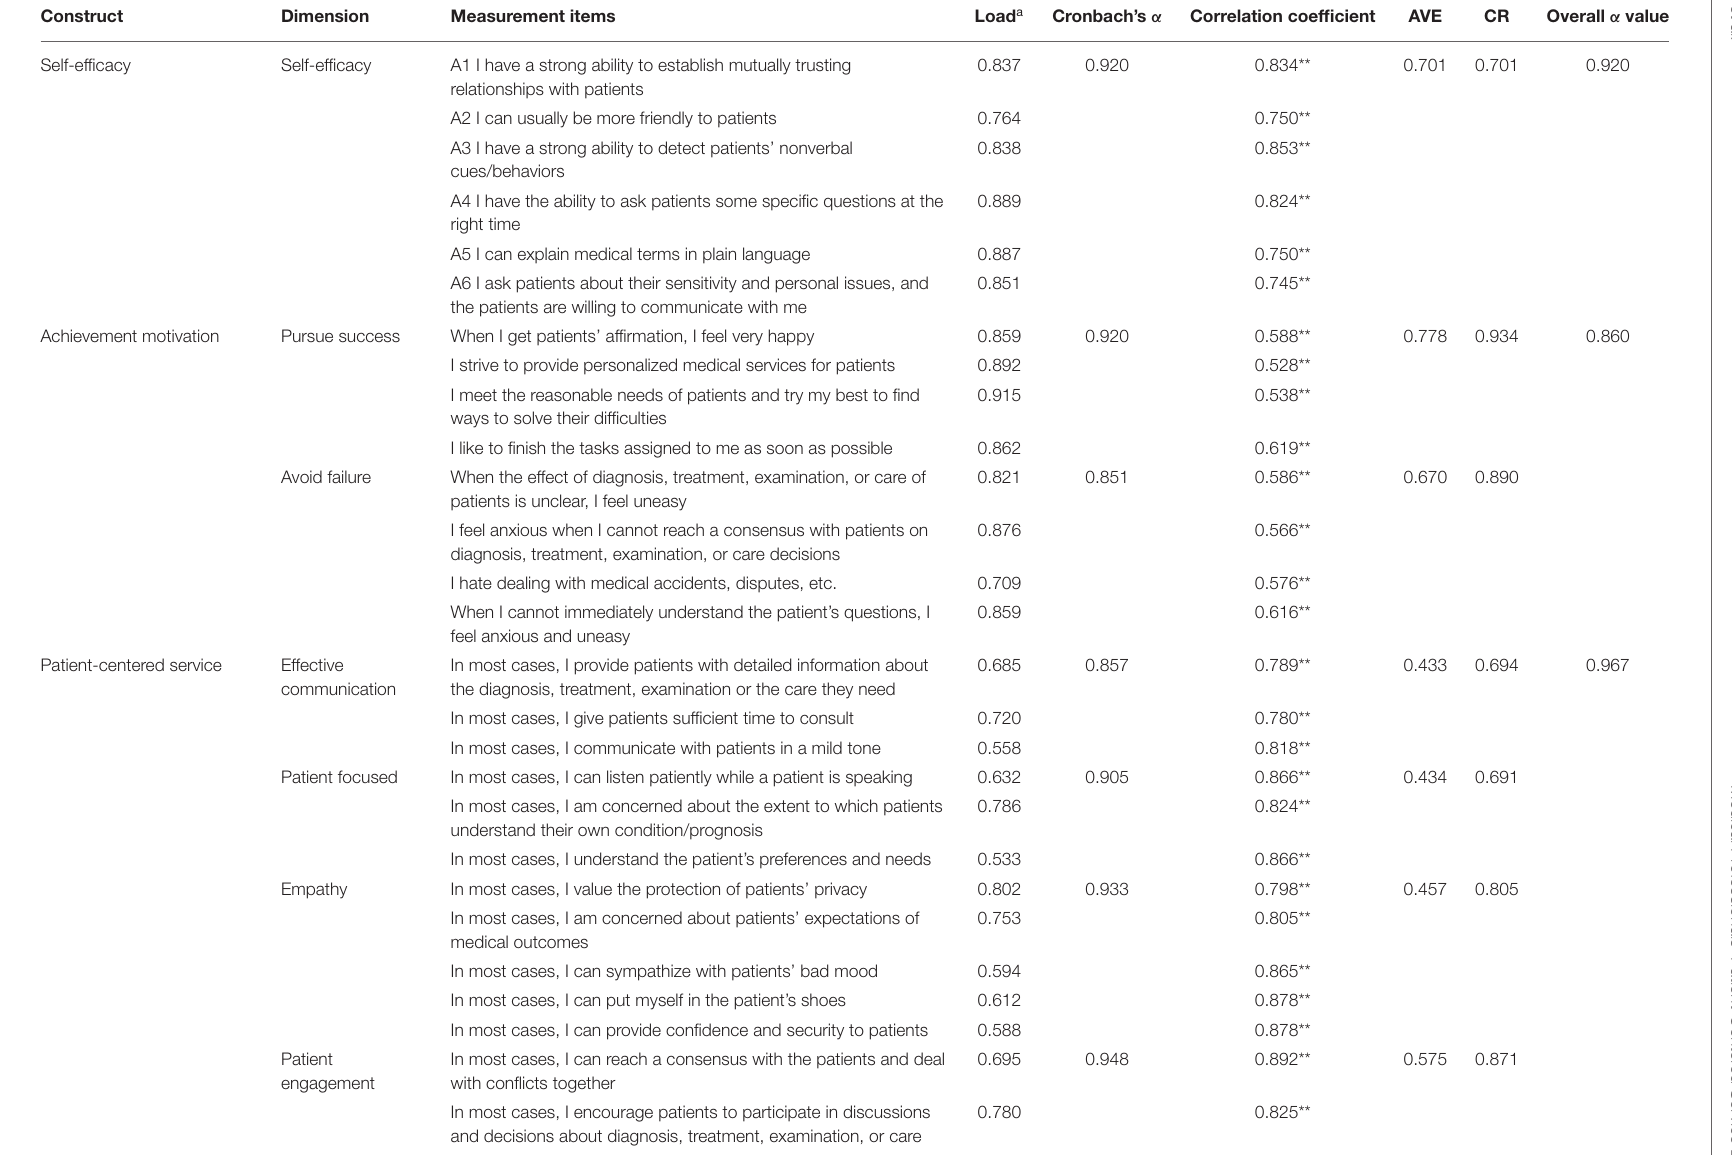
TABLE 2 | Measurement items and results of reliability and validity analysis of the questionnaire ( N = 1,612).